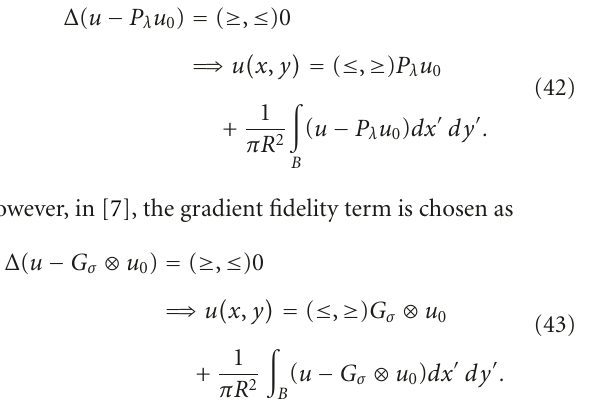
Figure 6: The subimages of the original, noisy, and restored “Toys” in Figure 5: (a) the original image; (b) the noisy image; (c) the restored image by the curvelet Shrinkage method; (d) the restored image by using the “TV” model; (e) the restored image by using the “TVGF” model; (f) the restored image by using our proposed model.